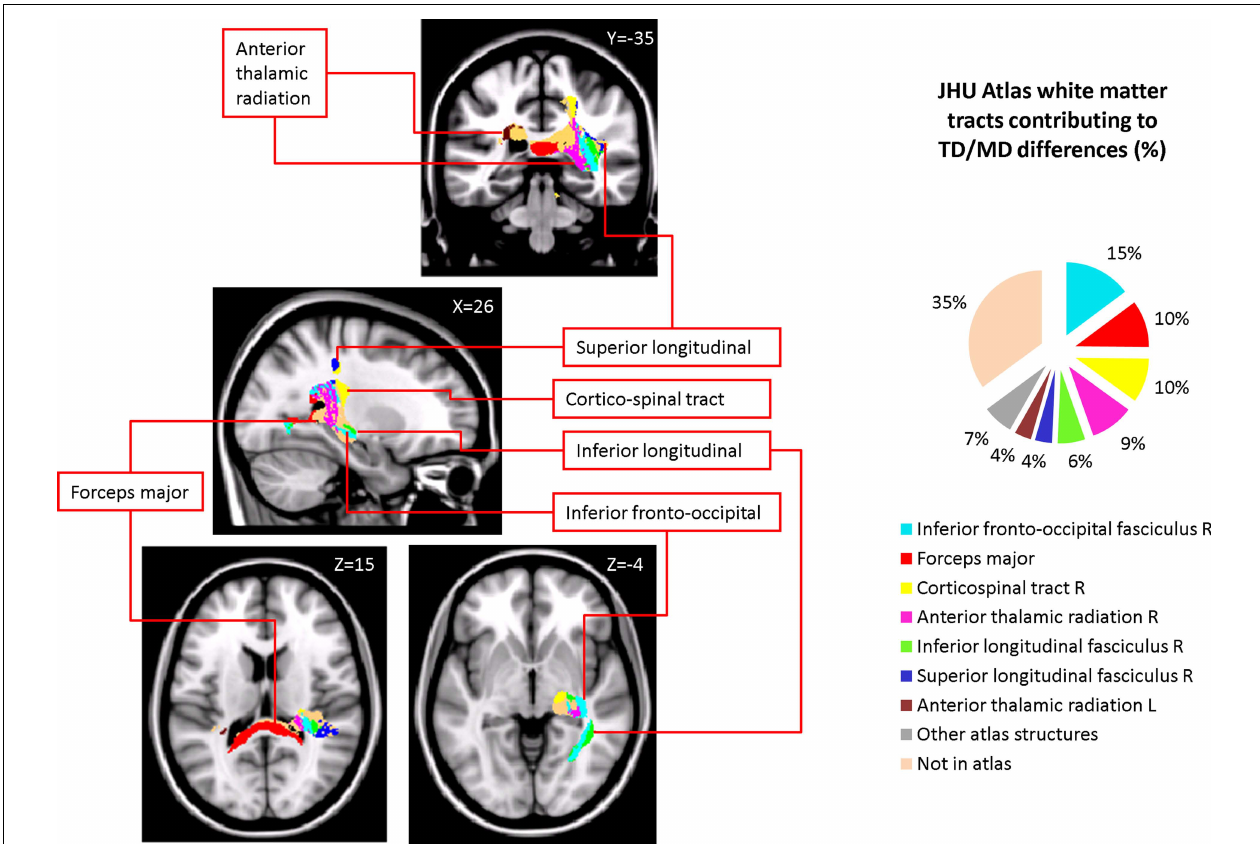
FIGURE 3 | White matter tracts in brain regions where children with DD showed signifi cant gray matter defi cits, compared to TD children. Tracts were labeled using the JHU white matter